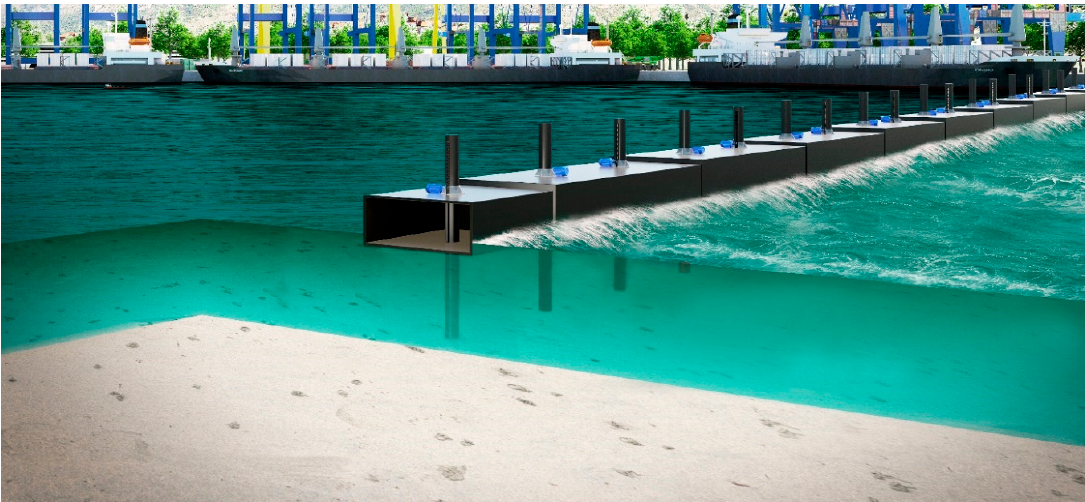
Figure 1. Schematic of heaving-buoy integrated floating breakwater.